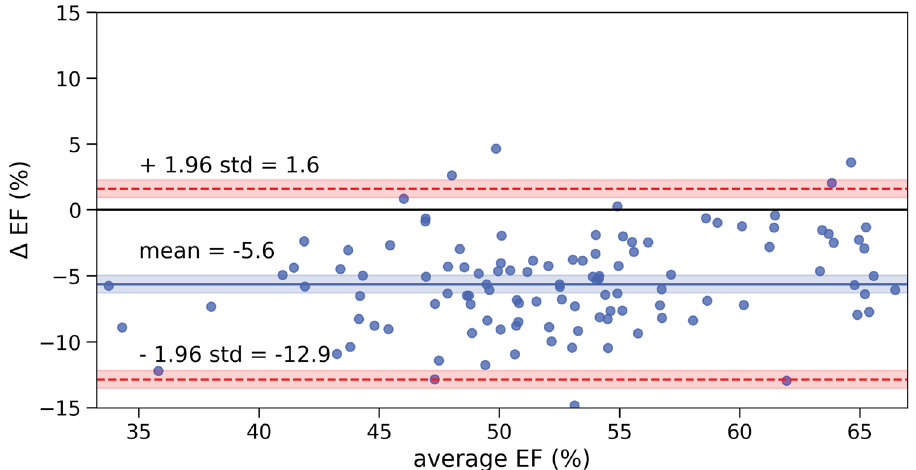
Figure 6. Bland–Altman plot for agreement analysis between operators for Study 5 (bias = -5.6 ± 3.8). The bias is marked with a solid blue line ( ─ ) and its 95% CI shaded in blue. The equality line is marked with a solid black line ( ─ ). The upper and lower 95% CI are marked with discontinuous red lines ( -- ) and are shaded with their respective 95% CI.